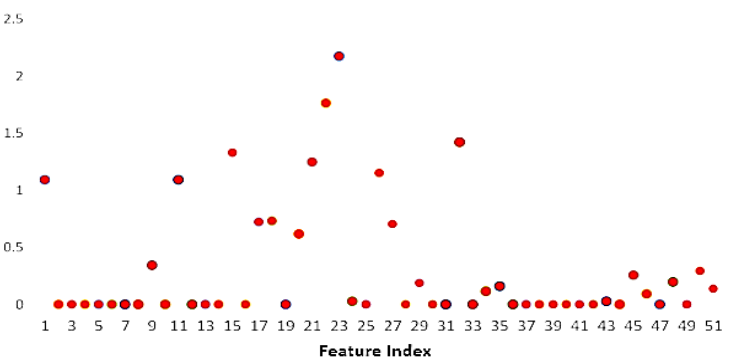
Figure 5. Feature weight matrix of predictor variables using Neighbourhood Component Analysis (NCA) for MSL in the case of Fiji Islands.